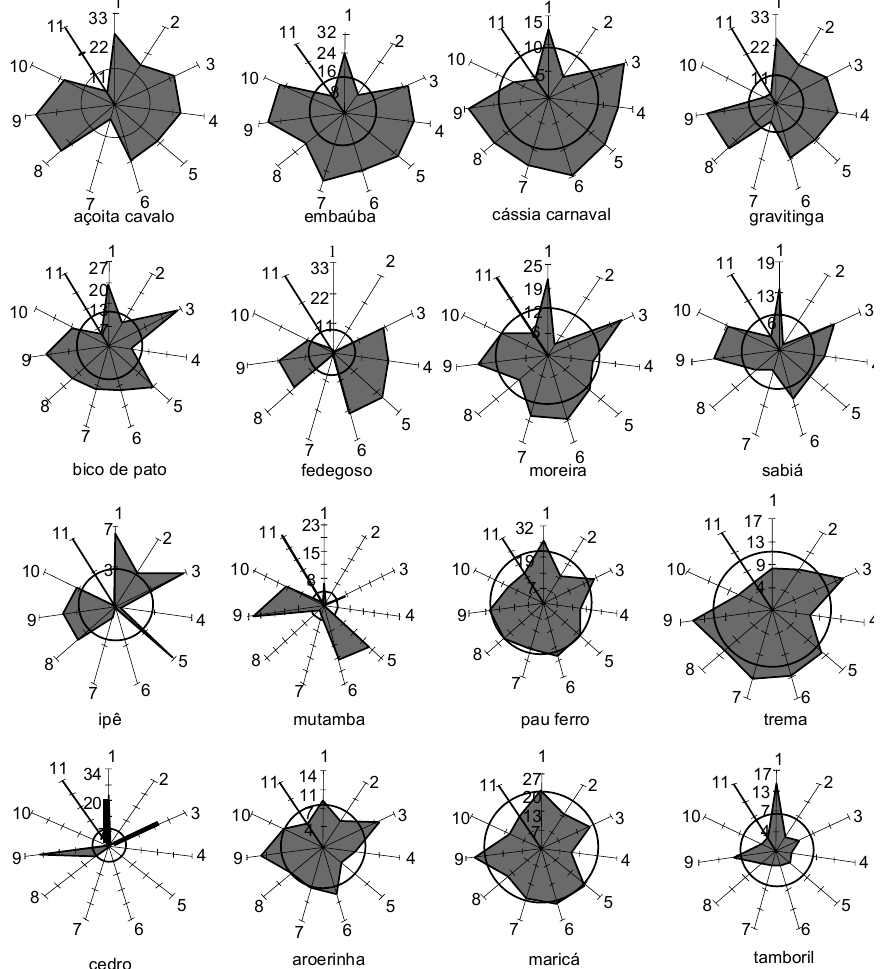
Figura 1. Peso de matéria seca da parte aérea, (g planta -1 , conforme escala no eixo numero 1 de cada gráfico aos 9-10 meses após a germinação), das espécies arbóreas inoculadas ou não com fungos micorrízicos arbusculares: 1- S. pellucida, 2- A. scrobiculata, 3- E. colombiana , 4- G. gigantea, 5- G. margarita, 6- G. etunicatum , 7- S. gregaria ,8- Espécies de agrossistema, 9- G. clarum, 10- Espécies da floresta , 11- Controle. Círculos com linhas contínuas ao centro das figuras correspondem à matéria seca do controle + dmS e comparam os efeitos dos tratamentos. Os tratamentos cuja produção extrapola o círculo diferem ( P ≤≤ ≤≤ ≤ 0,05, Tukey) do controle sem